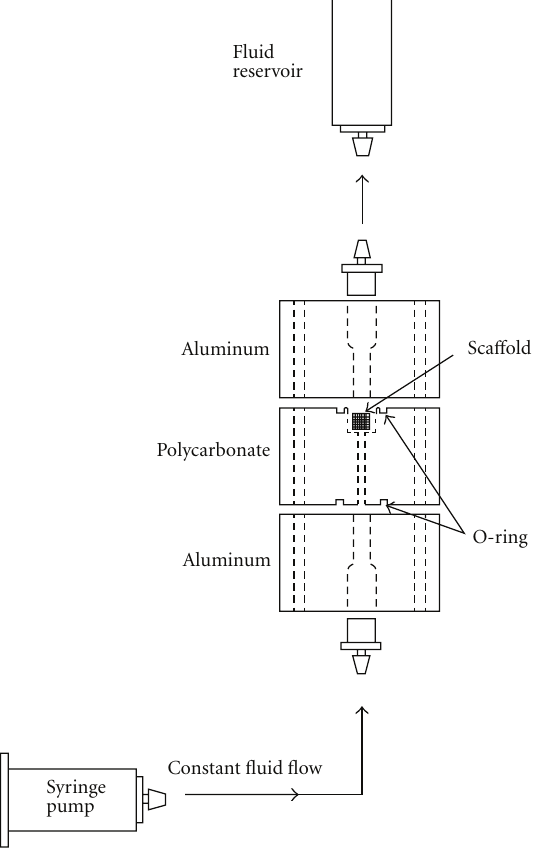
Figure 1: Bioreactor setup for perfusion incubation. The syringe pump delivered fluid at a rate of 0.075